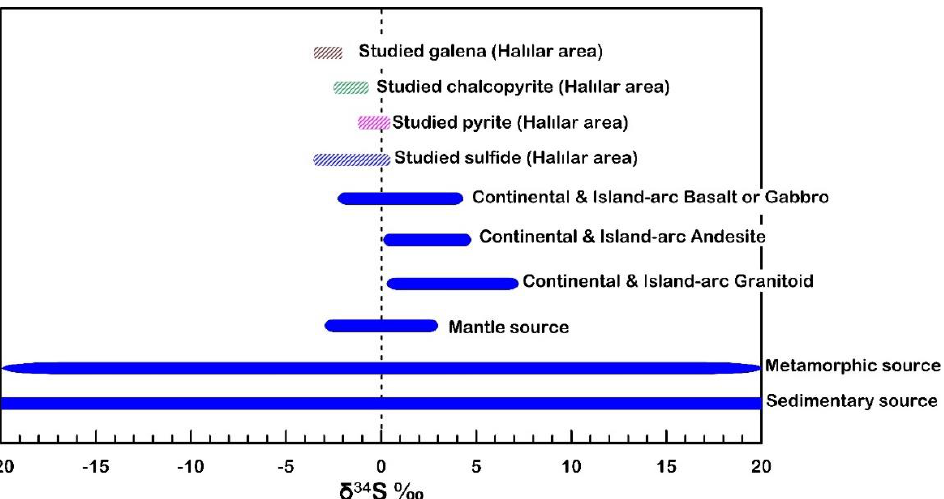
Figure 16. δ 34 S values of sulfides from the mantle, the continental igneous setting, and metamorphic and sedimentary sources. Mantle source [53], island arc basalts and gabbros [57,58], andesites [59,60], granitoids [61–63], and metamorphic and sedimentary sources [64].